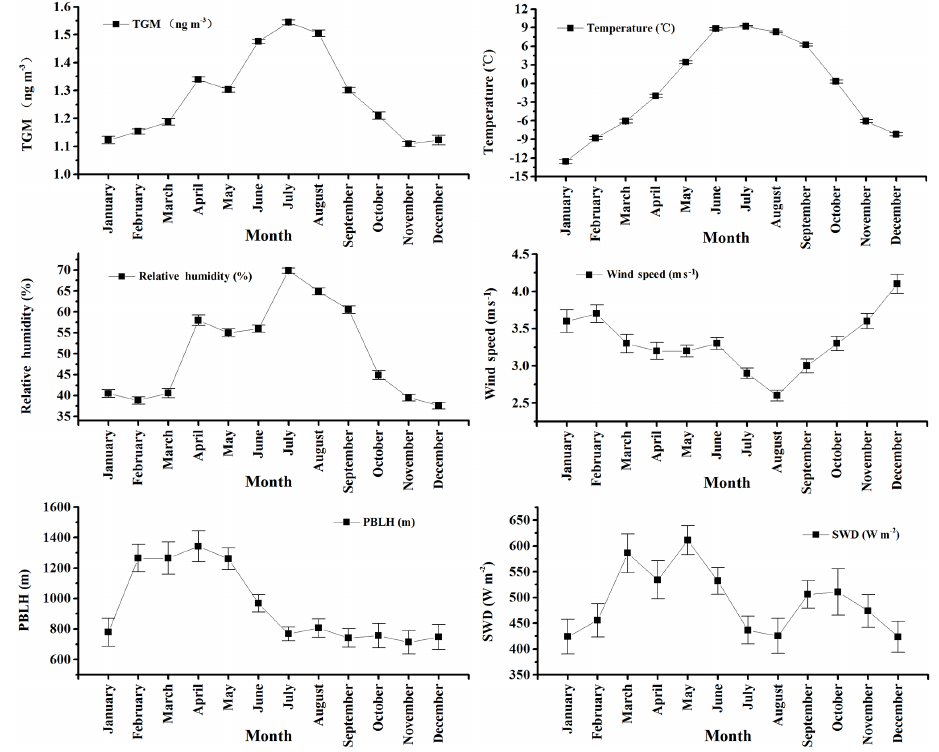
Figure 5. Monthly variations of TGM, relative humidity, temperature, SWD (downward shortwave radiation), wind speed and PBLH (plan- etary boundary layer height) during the whole measurement period at Nam Co Station. Error bars are 95% confidence levels. Table 2. Statistics of free parameters in the box model of TGM at Nam Co Station by